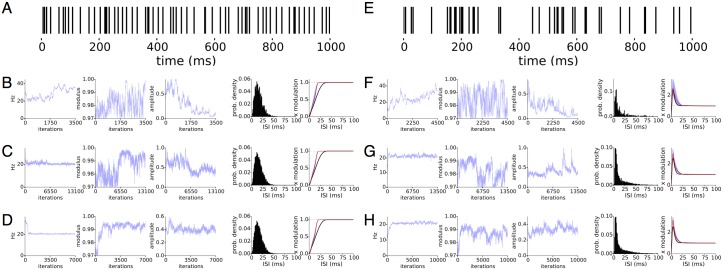
Effect of data size on posterior samples.2 simulations of spike train with spiking around 60Hz, modulated with a 20Hz oscillation with OCV around 0.14 and 1 second long trials, but with different refractory period profiles, A and E. Layout of the figures is the same as in Fig 3, but with B-D and F-G showing different number of trials used, B) 8, C) 15 trials, and D) 40 for spike train in A and F) 5, G) 60 and H) 80 trials for spike train in E. For the smallest number of trials, the posterior is noticeably more variable, but the amplitude of the latent state approaches 0, meaning the latent state is almost decoupled from the spiking. We can see that the posterior narrows as more trials are used.